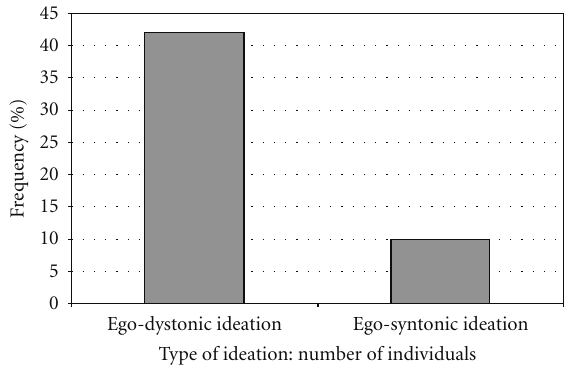
Figure 3: The proportion of individuals who reported ego-dystonic and ego-syntonic suicidal ideation during adequate treatment only, related to the total number of individuals who had at some time reported ego-dystonic and ego-syntonic ideation